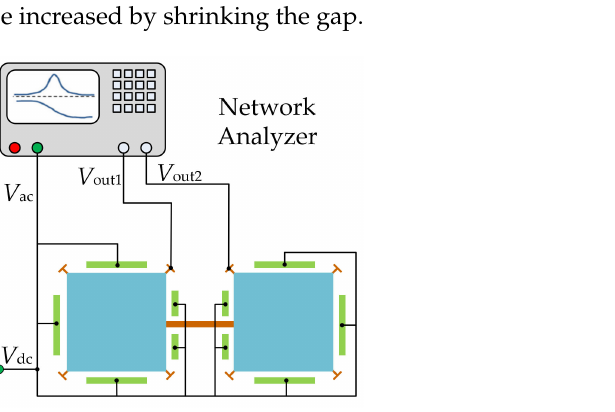
Figure 15. Schematic of a one-port configuration for a 2-DoF square-plate BAW resonator.